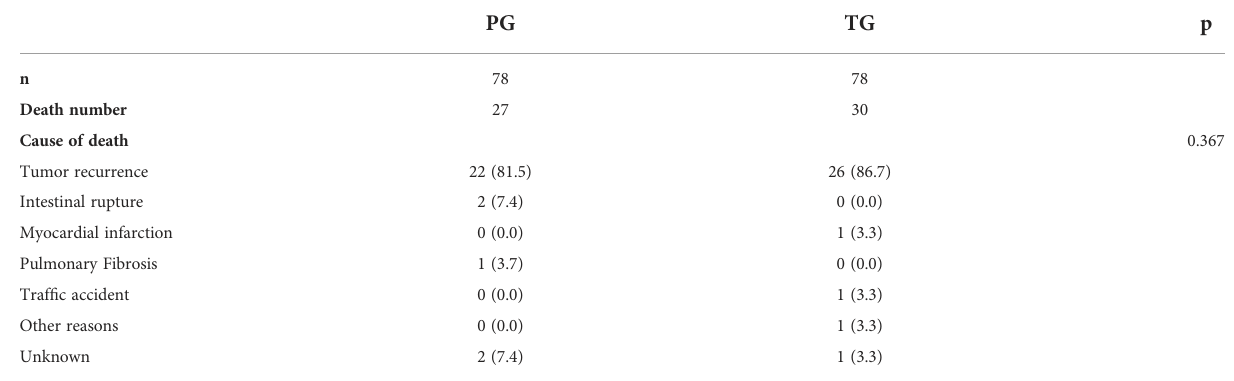
TABLE 3 Short-term